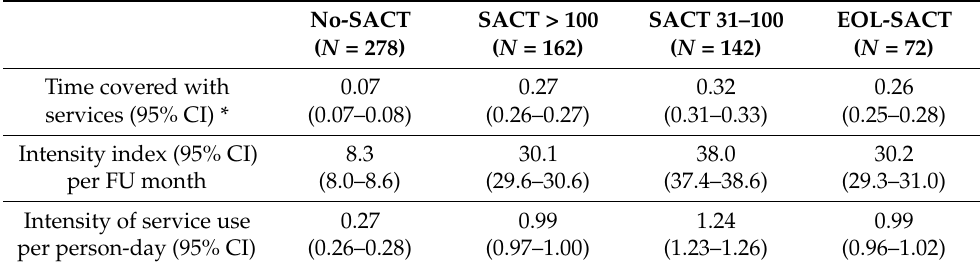
Table 6. Proportion of time covered by health care services per month, and intensity of service use per